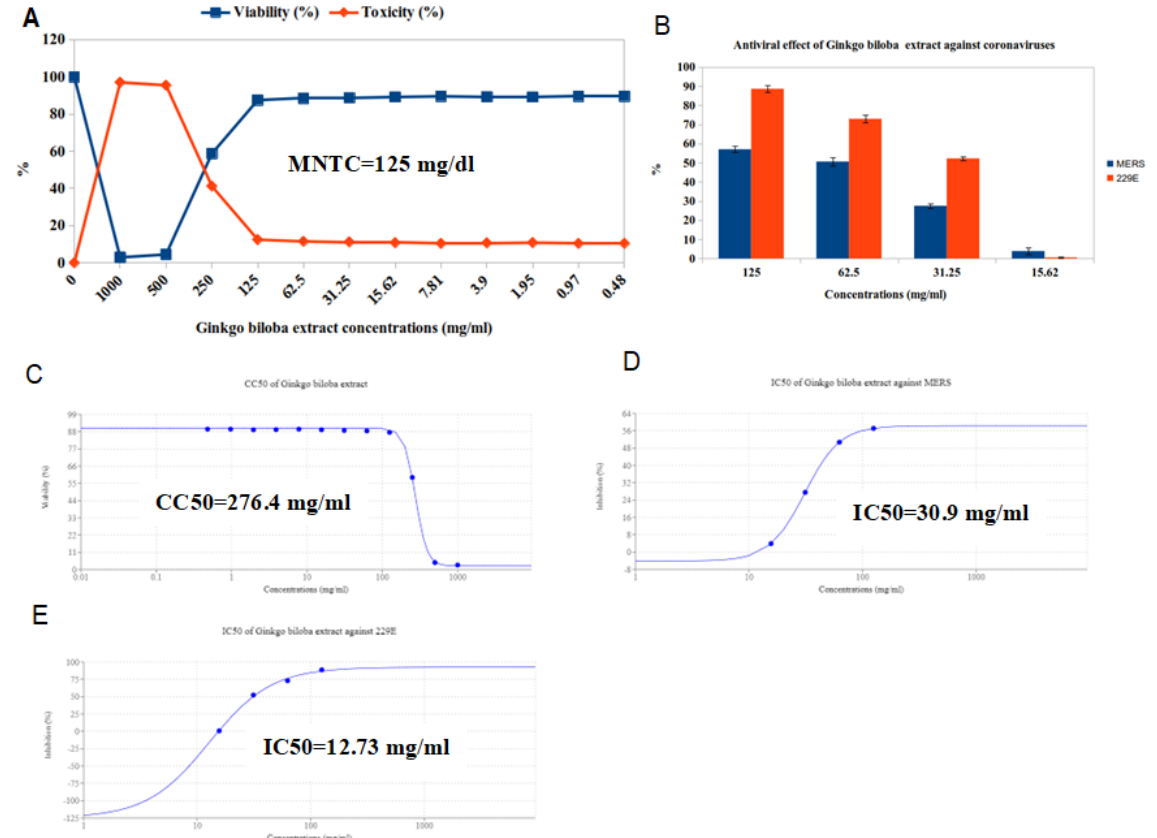
Figure 11. The anti–coronavirus activity of GB leaves extracts against MERS and 229E viruses using Vero cell lines. ( A ) Cytotoxicity; ( B ) antiviral activity; ( C ) CC50; ( D ) IC50 of the extract against MERS; ( E ) IC50 of the extract against 229E.